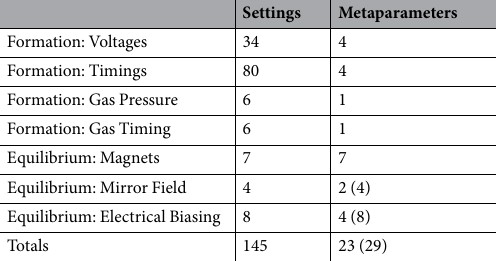
Table 2. Metaparameters for specifying experiments. Values in parentheses indicate asymmetric operation, which was not commonly attempted or required. Note that settings for the equilibrium magnets were not believed to be further reducible. For many experiments there were additional reductions, e.g. not adjusting mirror fields and electrical